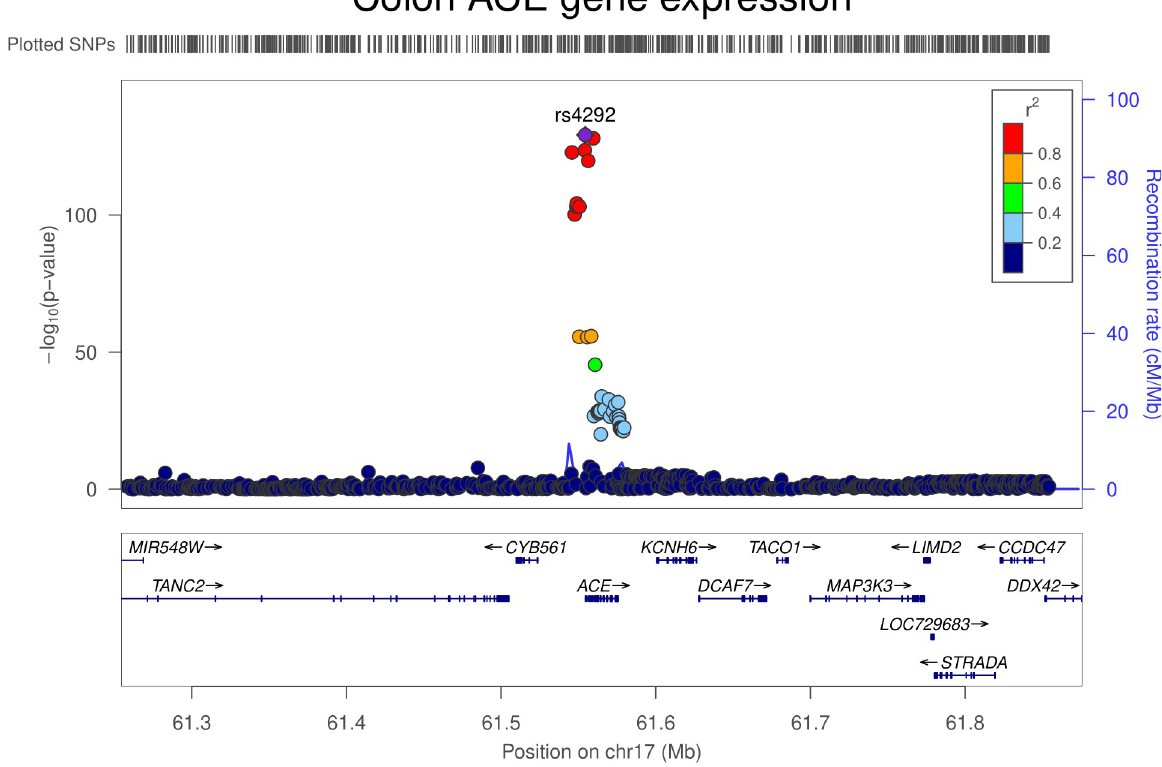
Fig 7. Regional Manhattan plot of associations of SNPs with colon ACE expression ± 300kb from the SNP used to proxy colon ACE expression (rs4292) in the ACE region. ACE, angiotensin-converting enzyme; Mb, Megabase; SNP, single-nucleotide polymorphism.